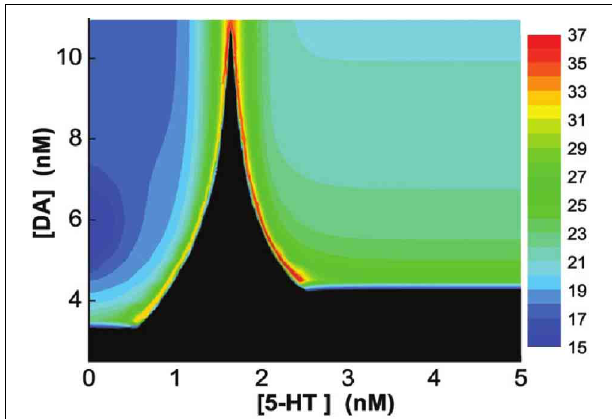
FIGURE 9 | Heterogeneous network behavior with respect to [DA] and [5- HT ]. Black region: Only asynchronous tonic stable firing states. Above the regions, oscillations can occur. Color bar denotes the oscillation frequencies (from 15 to 36Hz) which depend on the combination of [5- HT ] and [DA] levels. For [DA] > 10 . 946nM, there exists an optimal [5- HT ] value where the network can attain the maximum frequency